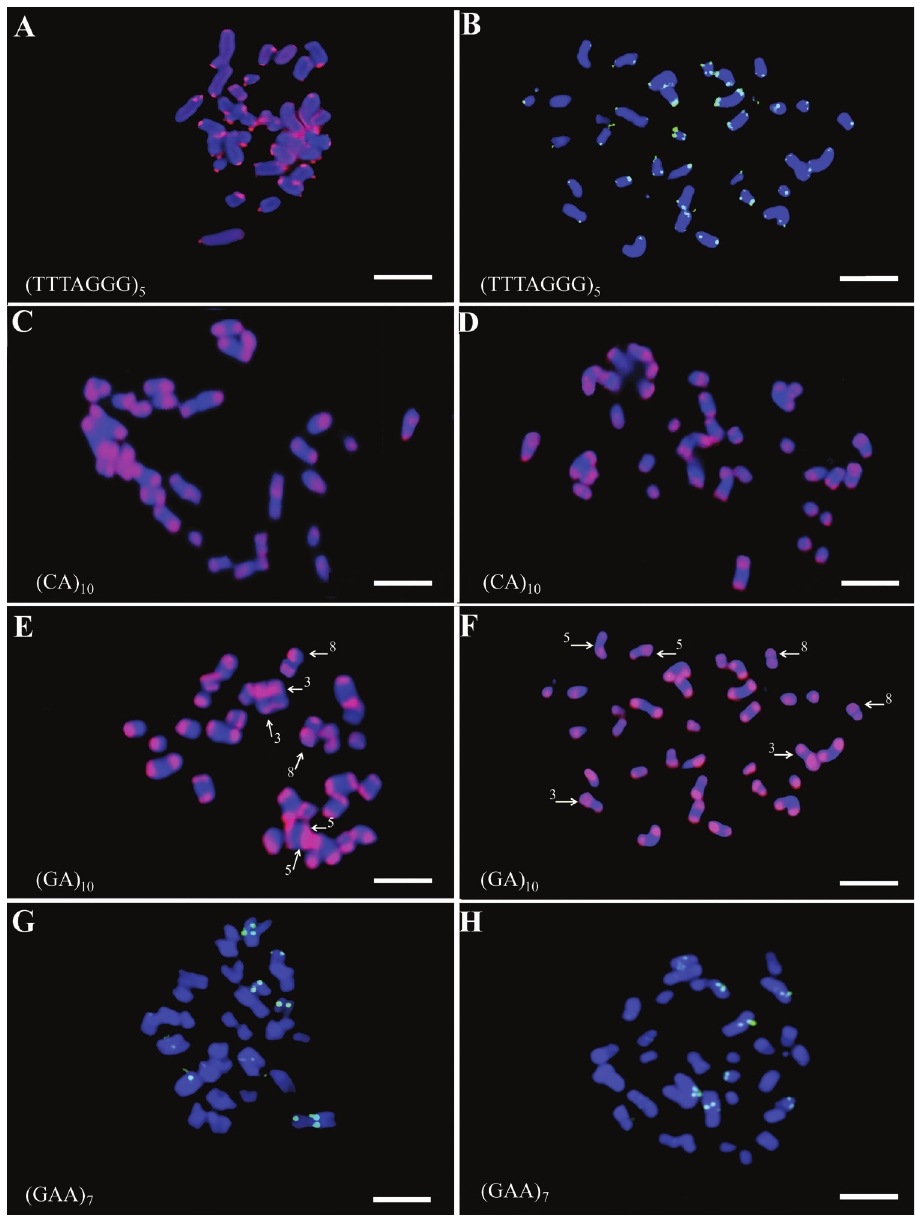
Figure 6. FISH molecular cytogenetic analysis with SSR probes. FISH on metaphase spreads of cardoon (left hand side) and of globe artichoke (right had side). The oligonucleotides sequence is indicated in each panel. Oligonucleotides were labelled with Cy3 (red fluorescence) or FITC (green fluorescence) fluorochromes. In ( E ) and ( F ) chromosomes 3, 5 and 8 of cardoon and globe artichoke, respectively, are indicated by arrows and can be discriminated by the widespread (GA) arms. Scale bars: 5